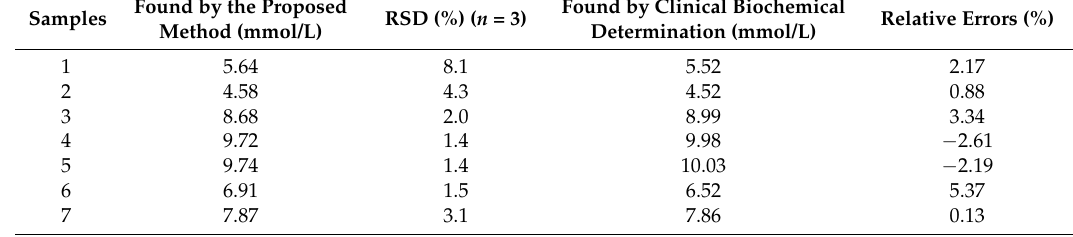
Table 1. Comparison of test results of the proposed method with clinical biochemical determination. Samples